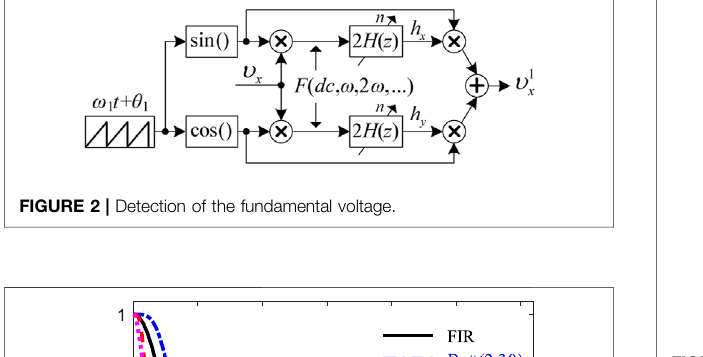
FIGURE 4 | Step response of the LPFs.